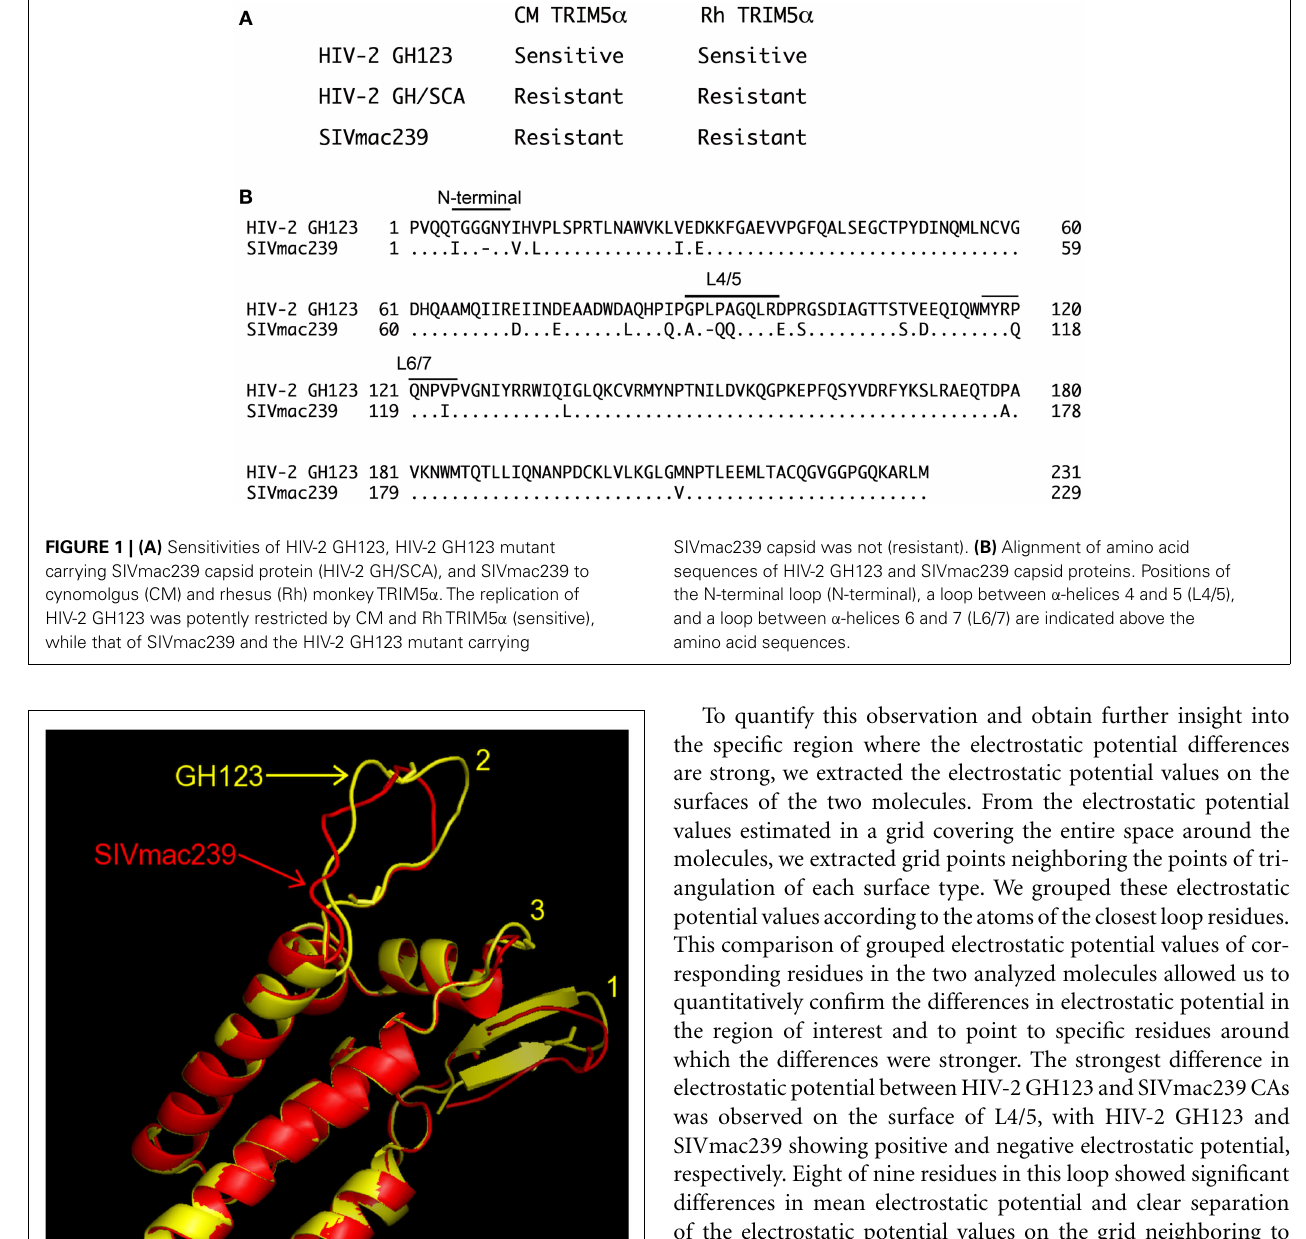
FIGURE 2 | Superposition of modeled structures of the N-terminal domains of HIV-2 GH123 (GH123, yellow) and SIVmac239 (red) capsid proteins. The three loops containing sites important for theTRIM5 α interaction are numbered as follows: (1) N-terminal loop, (2) loop between α -helices 4 and 5 (L4/5), (3) loop between α -helices 6 and 7 (L6/7).